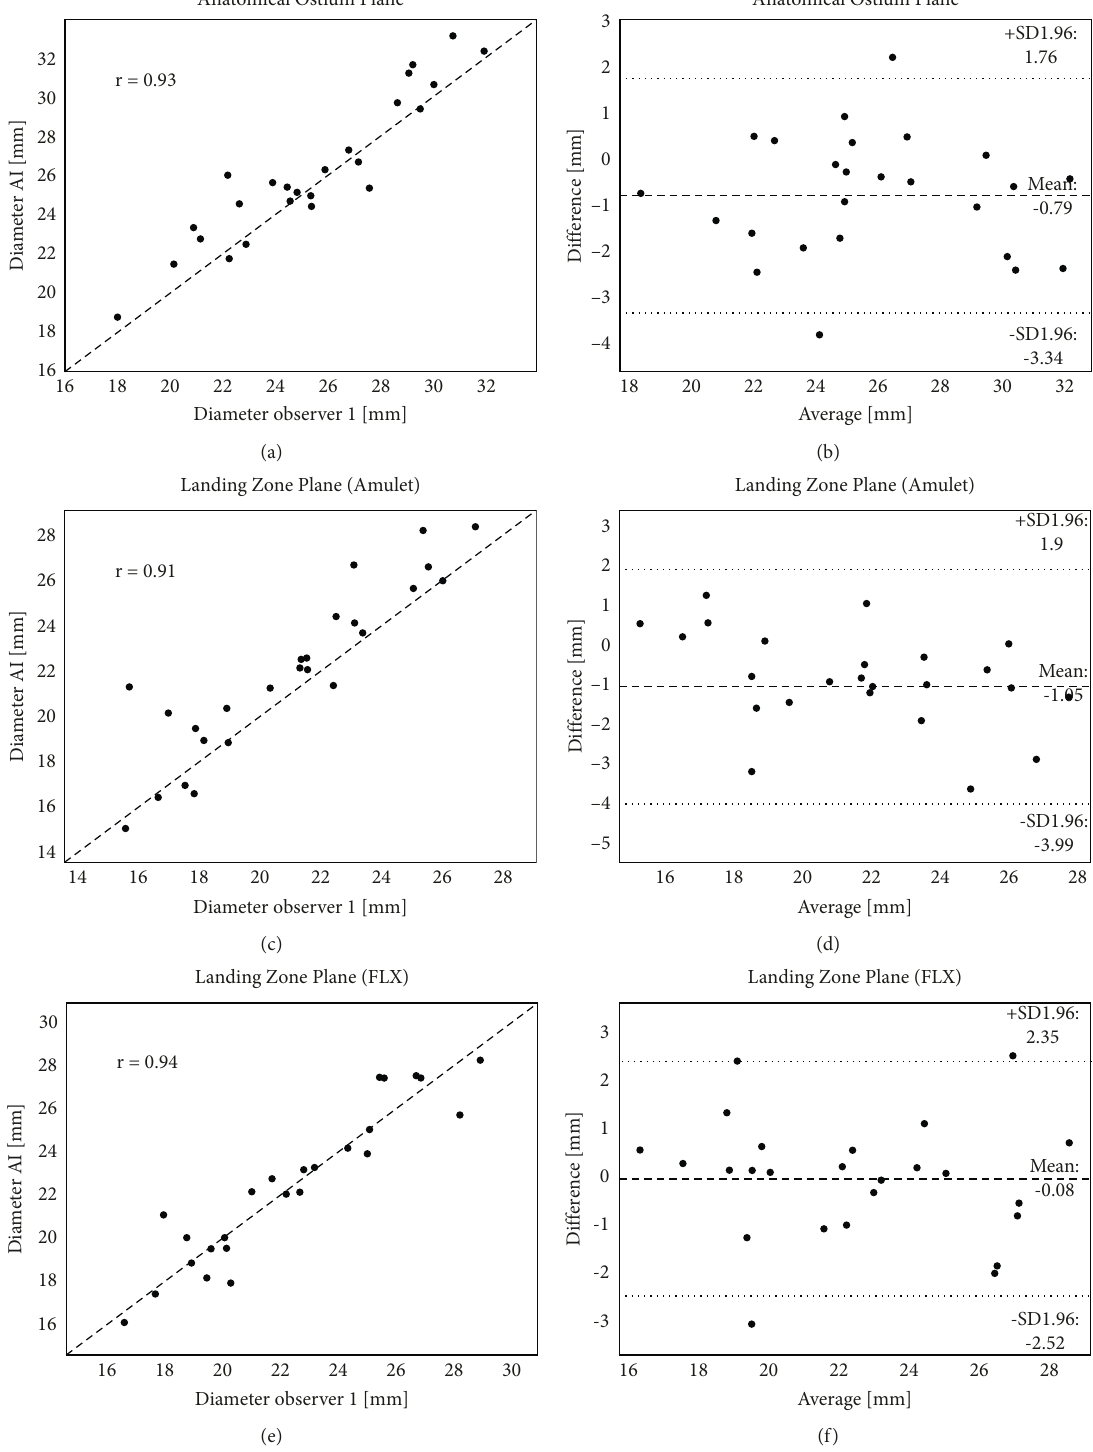
Figure 5: Overview of the results obtained for the comparison between the AI models and one of the manually identified measurements. All graphs report the results obtained for the perimeter-based diameter of the indicated cross-section (a-b: anatomical ostium, c-d: landing zone Amulet, e-f: landing zone Watchman FLX). Graphs (a-c-e) scatter plot with R Pearson coefficient. Graphs (b-d-f) Bland–Altman analysis with mean value and limits of